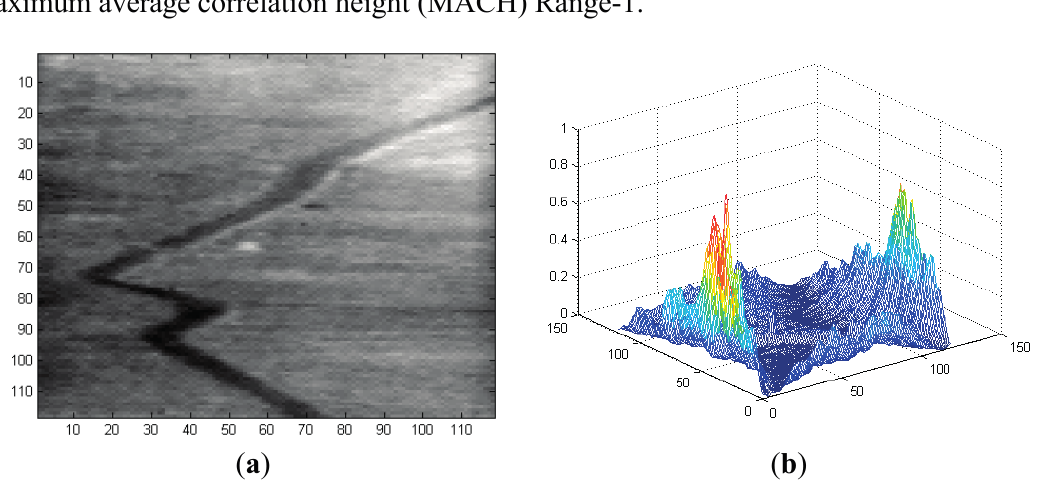
Figure 6. ( a ) Frame 1 of Sequence L2018; and ( b ) correlation output with the filter maximum average correlation height (MACH) Range-1.